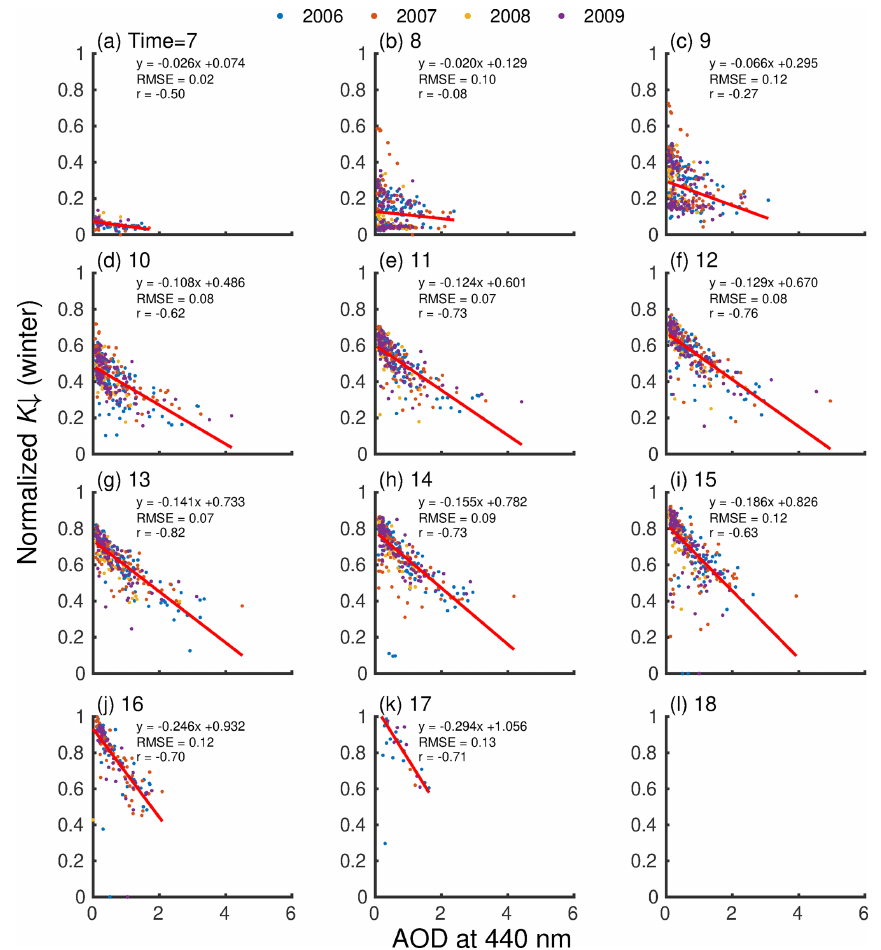
Figure A1. As Fig. 1 but for the thermal winter months (October–March).